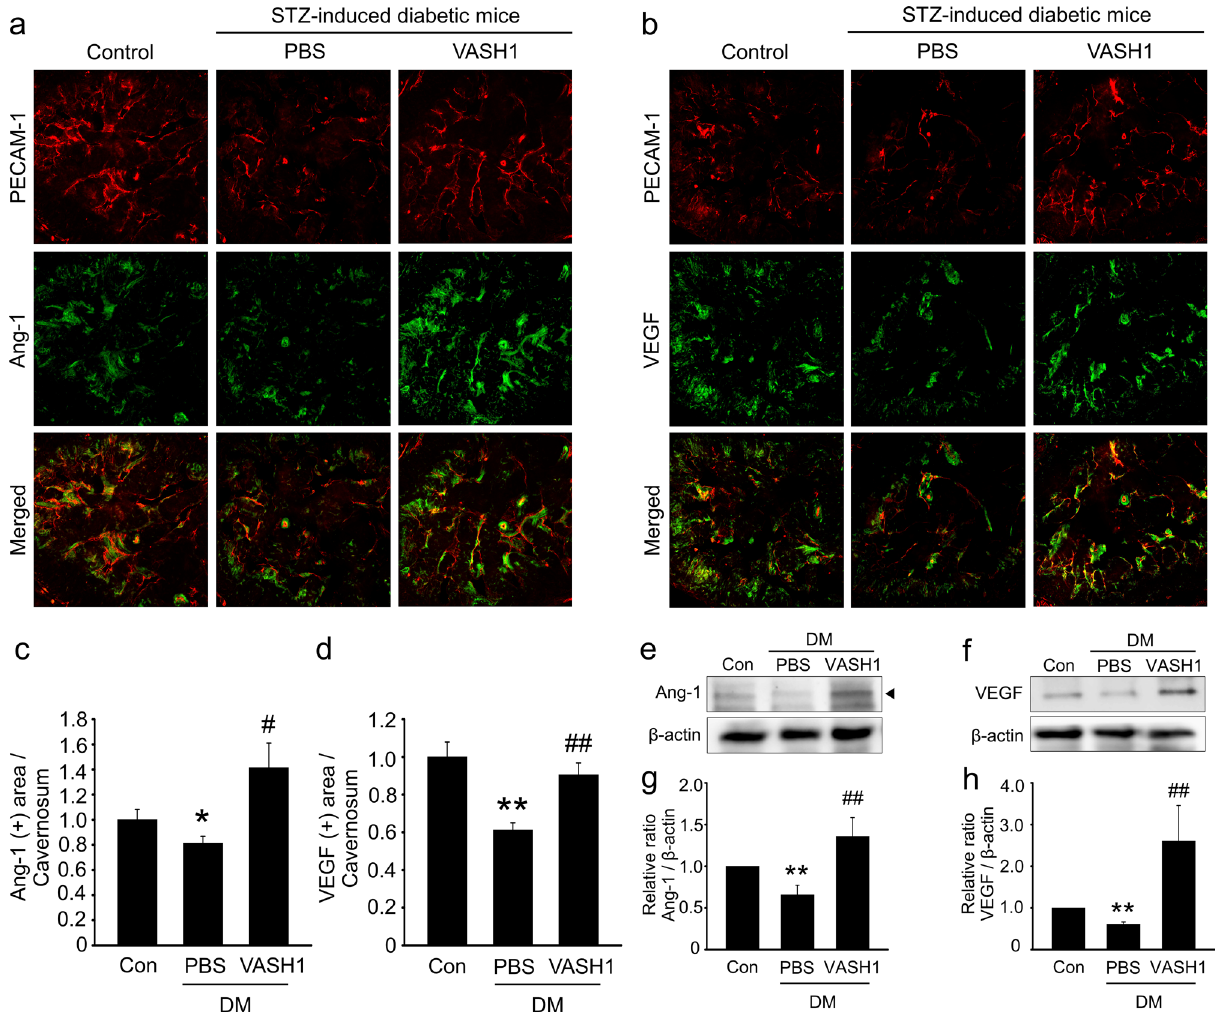
Figure 6. VASH1 protein transfer increases the cavernous expression of angiogenic factors in diabetic mice. ( a , b ) Angiopoietin-1 (Ang1, green) and PECAM1 (red), or vascular endothelial growth factor (VEGF, green) and PECAM-1 (red) staining in cavernous tissue from age-matched control and streptozotocin-induced diabetic mice 2 weeks after receiving repeated intracavernous injections of PBS (days − 3 and 0) or VASH1 protein (days − 3 and 0; 4 μg/20 μL). Scale bar = 100 µm. ( c , d ) Ang1 and VEGF-immunopositive areas were quantified by Image J. Each bar depicts the mean (± SE) values from N = 6 animals per group. * P < 0.05, ** P < 0.01 vs. control group. # P < 0.05, ## P < 0.01 vs. PBS-treated DM group. ( e , f ) Representative Western blots for Ang1 and VEGF in each group of mice. ( g , h ) The relative ratio of Ang1 and VEGF compared with that of β-actin. Each bar depicts the mean (± SE) values from N = 4 animals per group. ** P < 0.01 vs. control group. # # P < 0.01 vs. PBS-treated DM group. DM diabetes mellitus. Full length blot as well as the related images available in the supplementary